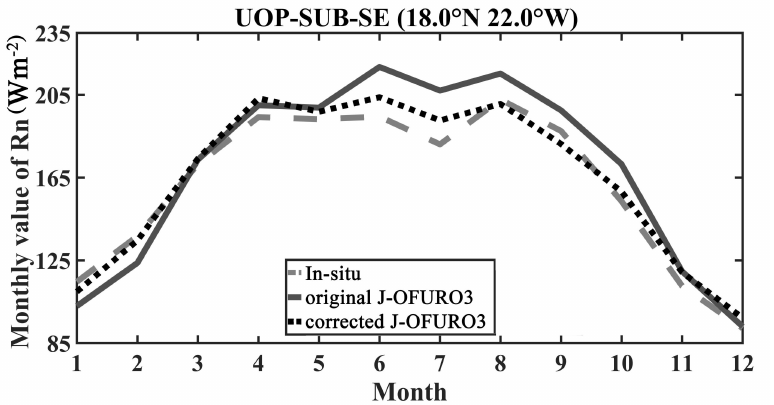
Figure 13. Times series variations in the monthly sea-surface R n in 1992 from the original corrected J-OFURO3 data and the in situ R n at the UOP-SUB-SE moored buoy site (18°N, 22°W).